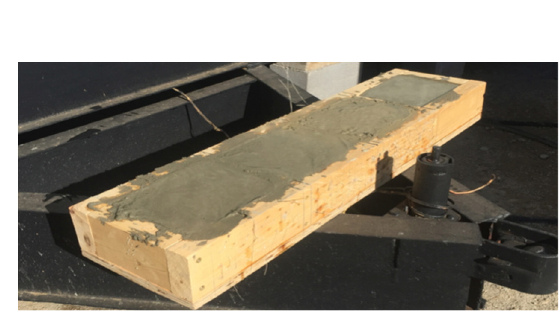
Fig. 10: Once complete, the mold was left to cure for 5 days 3.4 Remov Mold After five days the concrete blocks had finished